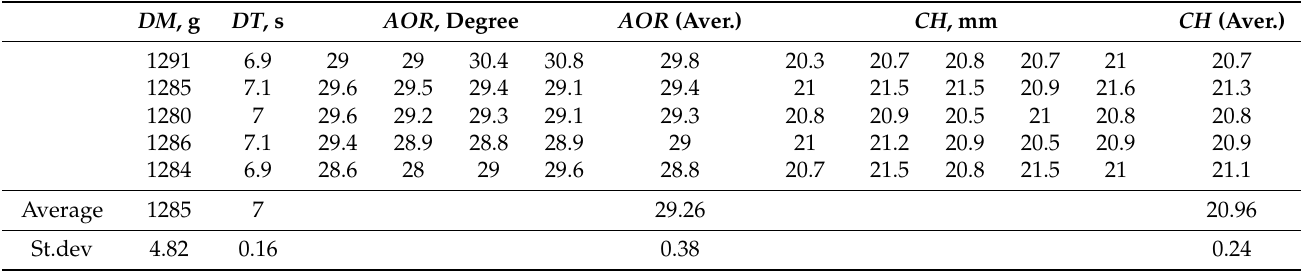
Table 3. The results of the sandglass